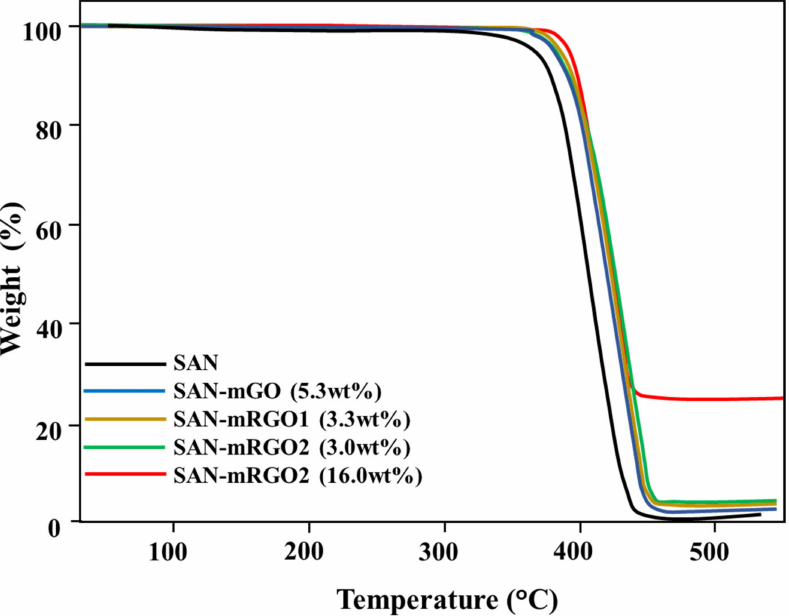
Figure 5. TGA curves of styrene–acrylonitrile copolymer (SAN), and grafted mGO, mRGO1 and